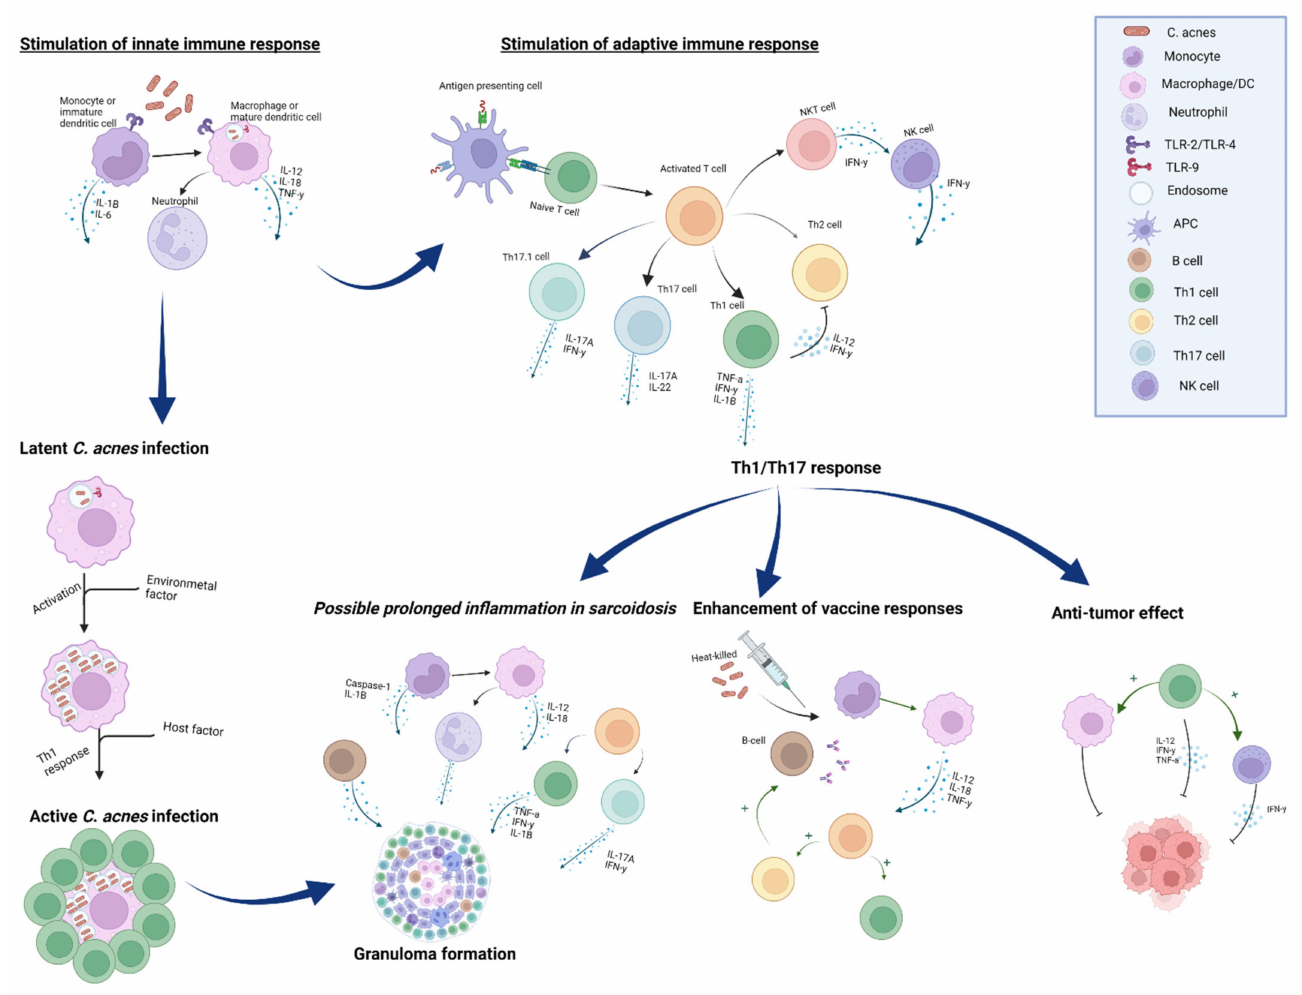
Figure 2. Proposed interaction between Cutibacterium acnes and the immune system resulting in different immunoregulatory effects. C. acnes has extensive immunostimulatory activity. It can stimulate different innate immune receptor such as TLR-2, TLR-4 and intracellular TLR-9 and NOD- like receptors. C. acnes can induce a Thelper-1 (Th1) cytokine milieu and subsequent Th1 response which is thought to be beneficial in enhancing both anti-tumor response and vaccination. Furthermore, C . acnes seems capable of skewing a Th2 response to a Th1 response. Recent data also suggest that C . acnes is involved in initiating a more Th17-based response. The intercellular C. acnes infection is thought to induce granuloma formation in sarcoidosis. The mechanism of this antigenic role of C. acnes was hypothesized by Eishi et al. (adapted with permission from [66]). However, C. acnes is also thought to play a mitogenic role to granuloma formation in sarcoidosis, mainly based on induction of a Th1/Th17